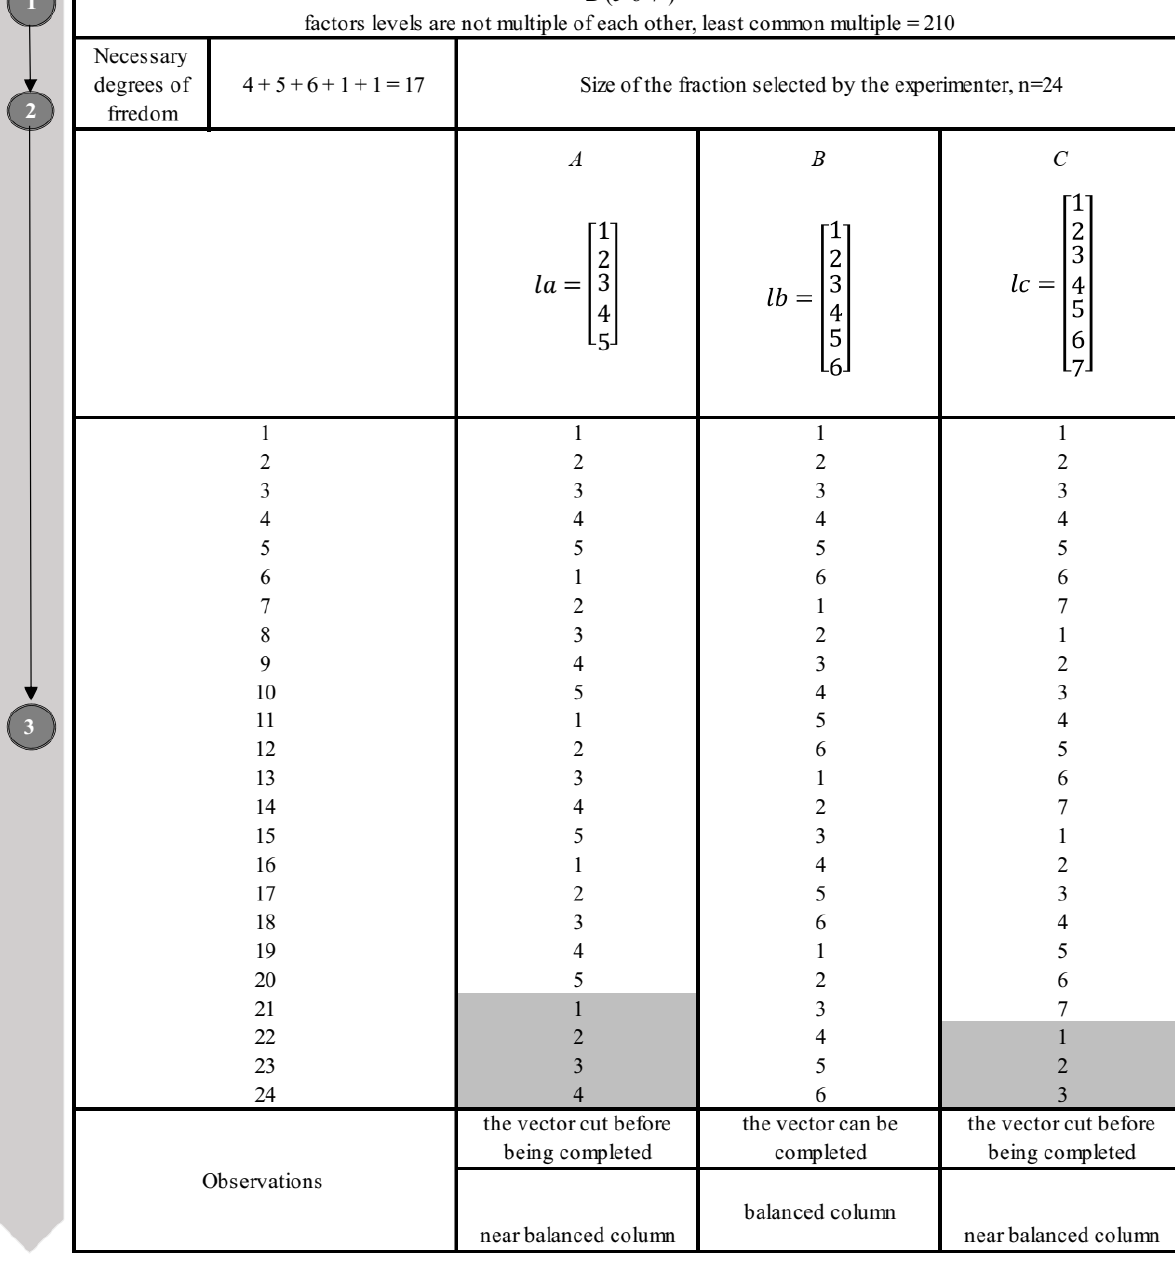
Figure 3. Construction of NONBPA (24,5 1 6 1 7 1